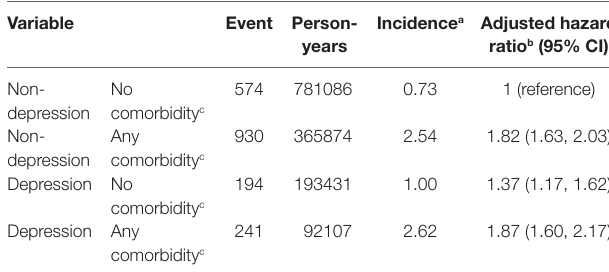
TaBle 4 | Risk of pulmonary tuberculosis stratified by depression and comorbidities.